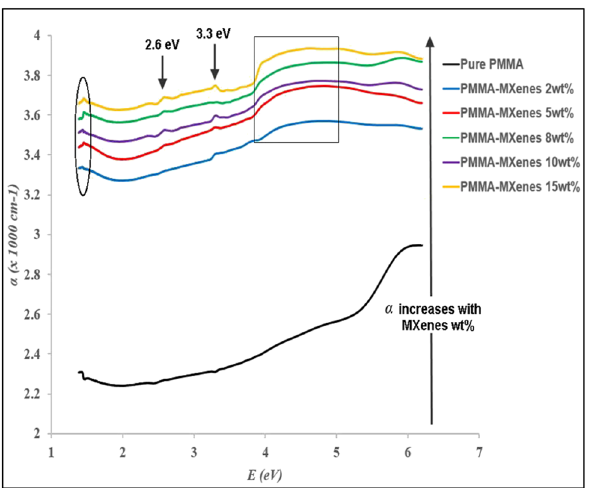
Figure 7: The absorption coe ffi cient ( α ) of all samples as a function of photon energy ( E ) .